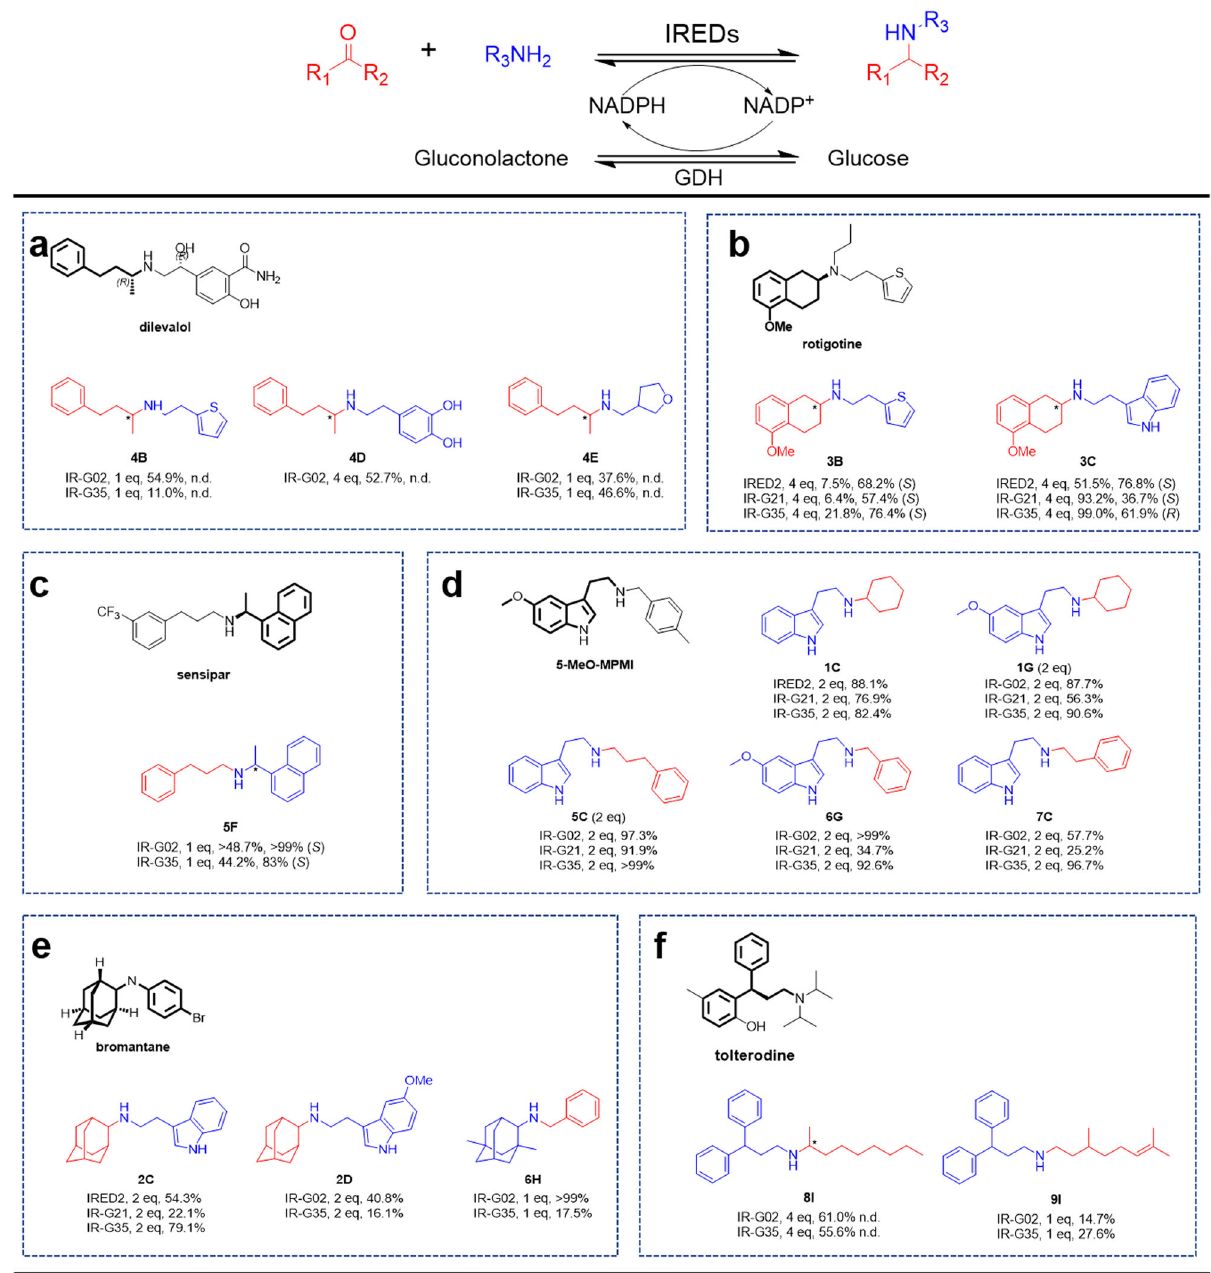
Fig. 3 Applying IREDs for analytical-scale synthesis of APIs ′ substructures. a Reductive aminations of 4 with B , D , and E . b Reductive aminations of 3 with B and C . c Reductive amination of 5 with F . d Reductive aminations of 1 , 5 , 6 , and 7 with C and G . e Reductive aminations of 2 and 6 with C , D , and H . f Reductive aminations of 8 and 9 with I